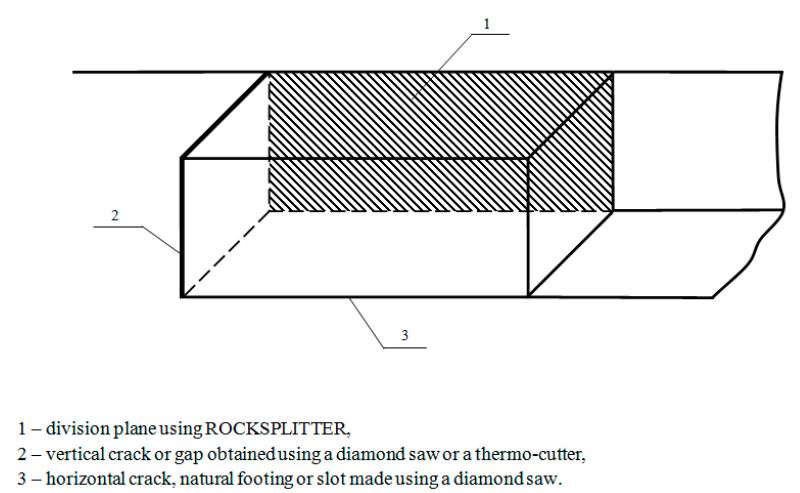
Figure 5. Massif prepared for mining blocks (Adapted from [16]).